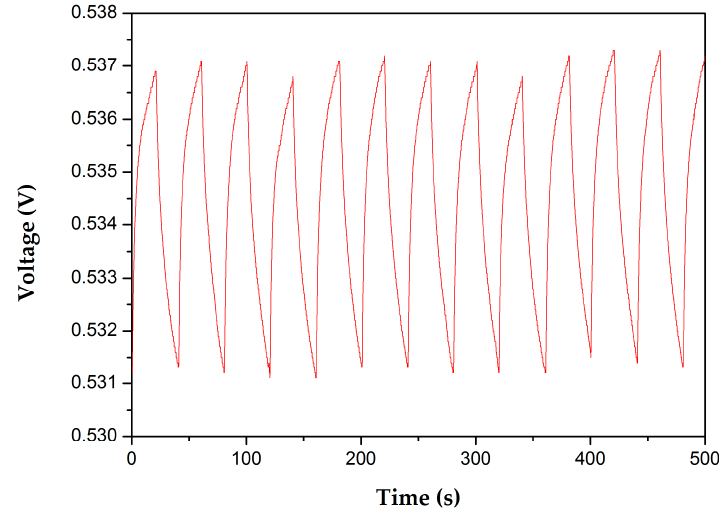
Figure 7. A typical photovoltaic response for PA–c film immobilized on ITO glass upon exposure to light with switching at room temperature.